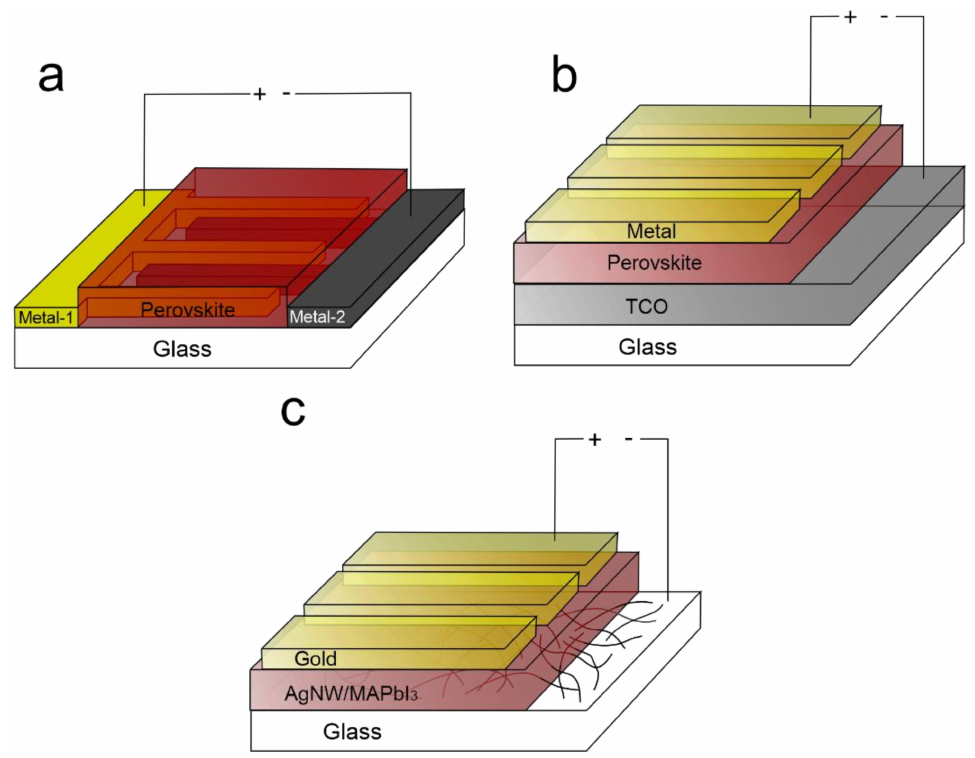
Figure 1. Schematic representation of MSM PPDs with different device designs; ( a ) lateral design; ( b ) vertical design; ( c ) hybrid